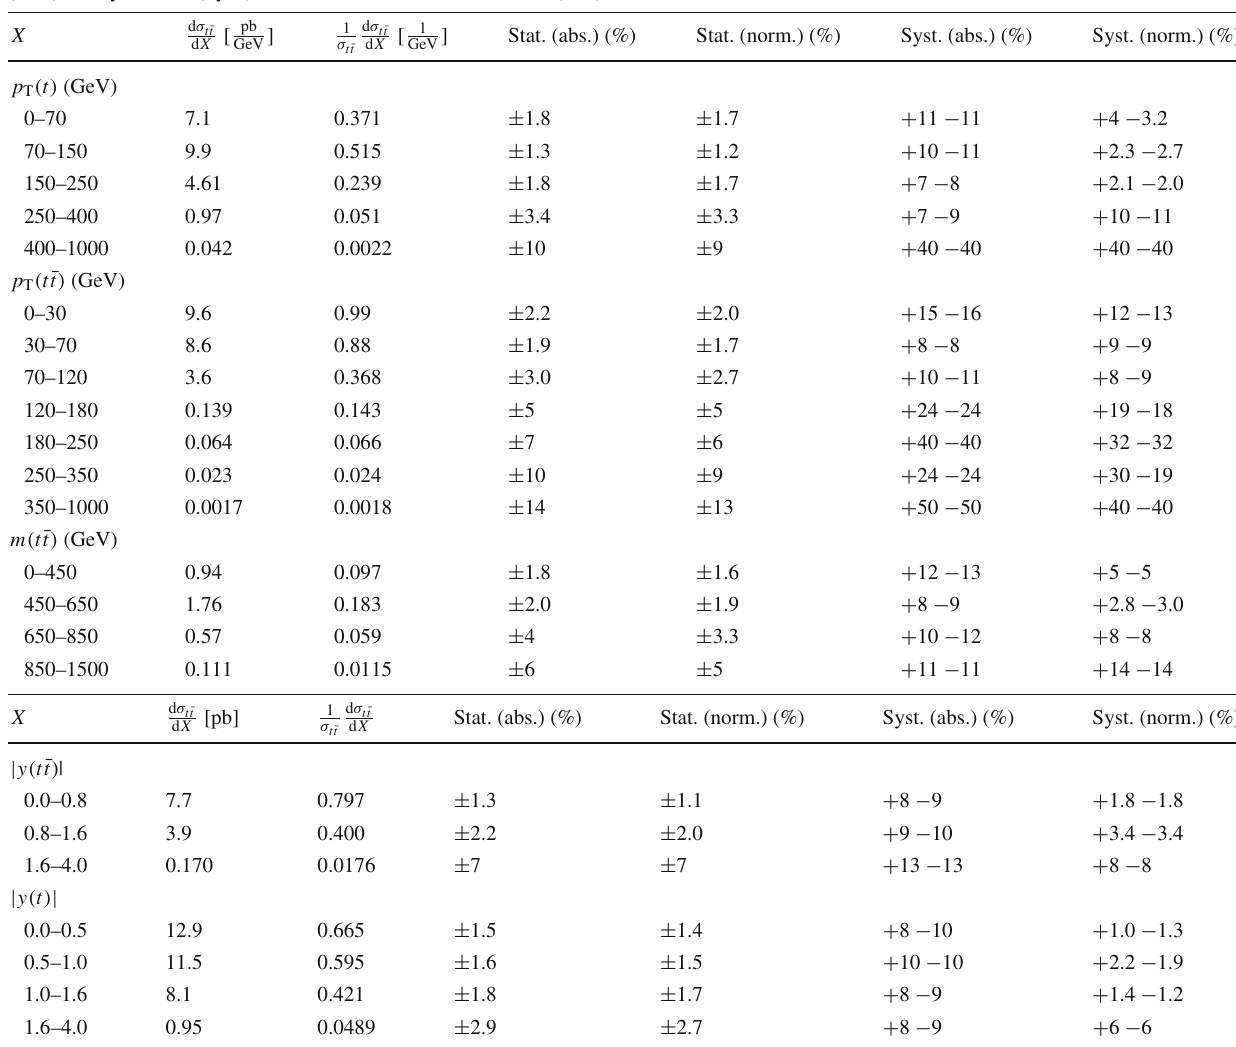
Table 4 Summary of the measured absolute ( d σ t ¯ t d σ t ¯ t ( 1 σ ) differential cross-sections, along with the relative statistical d X t ¯ t (Stat.) and systematic (Syst.) uncertainties for both the absolute (abs.)